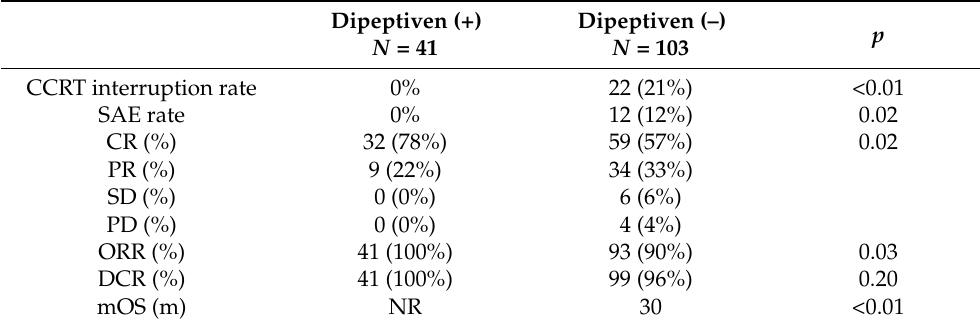
Table 2. Oncologic outcomes of 144 patients with nasopharyngeal cancer receiving concurrent chemoradiotherapy, stratified by dipeptiven.